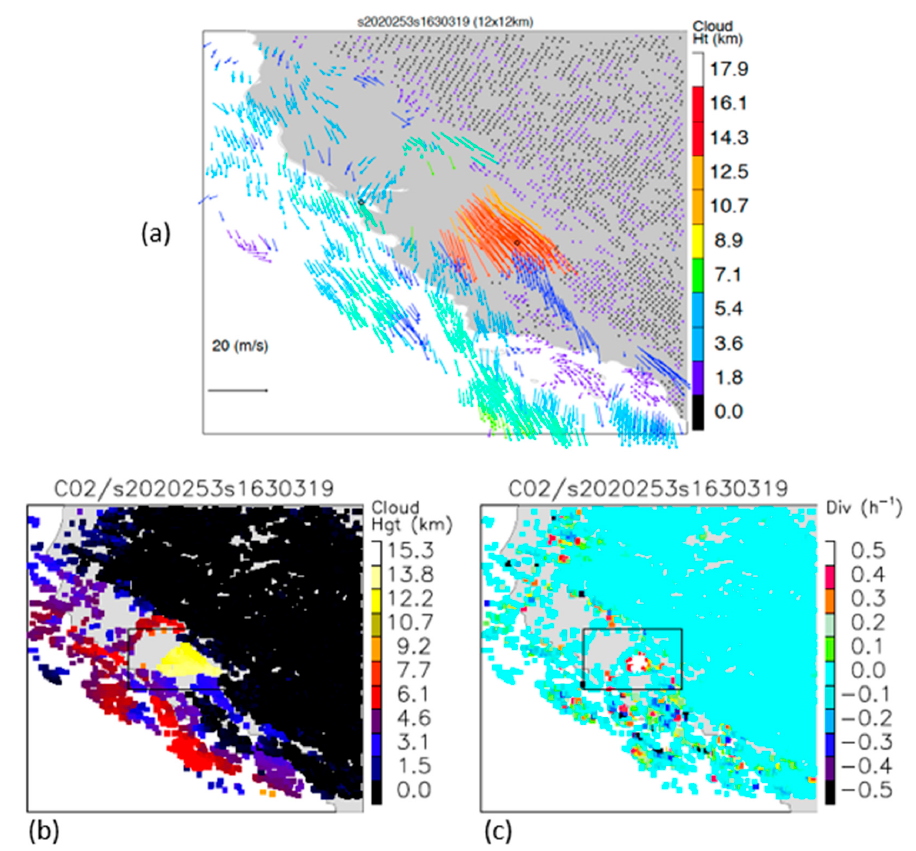
Figure 21. The B02 stereo-wind retrievals from 16:30 Z on September 9 for ( a ) wind velocity, ( b ) plume height above terrain, and ( c ) divergence. The embedded box indicates the area used to monitor the area-mean time series of these variables. In the operational products, the B02 DMWs do not have measurements at heights > 3 km, and the B14 DMWs have no retrievals from GOES-16 nor -17 for this pyroCb. Fire pyroCbs are rare events and require LEO sensors to observe at the right place at the right time [59]. The rapid refresh with the stereo-wind technique from GOES-16 and -17 not only facilitates capturing more pyroCb events but also tracking their development and structural evolution. Figure 22 shows the time evolution of the plumes from Creek Fire. The area-mean divergence and curl indicate pulse forcings at 15:20 Z and 19:00 Z, followed by a steady increase in area-mean plume height and wind changes (direction and speed) on that day. The intensive fire forcing at 15:20 Z generated an explosive pyroCb with the area-mean plume height peaking above 10 km in a 30-min period. As the plume height increased, the associated curl decreased (divergence increases slightly), and the plume wind speed increased with direction. Due to the intense and variable heating from wildfires, the fire–atmosphere interaction has been a challenging research topic [60]. The sudden change in the upper-tropospheric wind velocity, coincident with the forcing increase, suggests that a fire behavior change could impact dynamics through fire–atmosphere coupling processes.